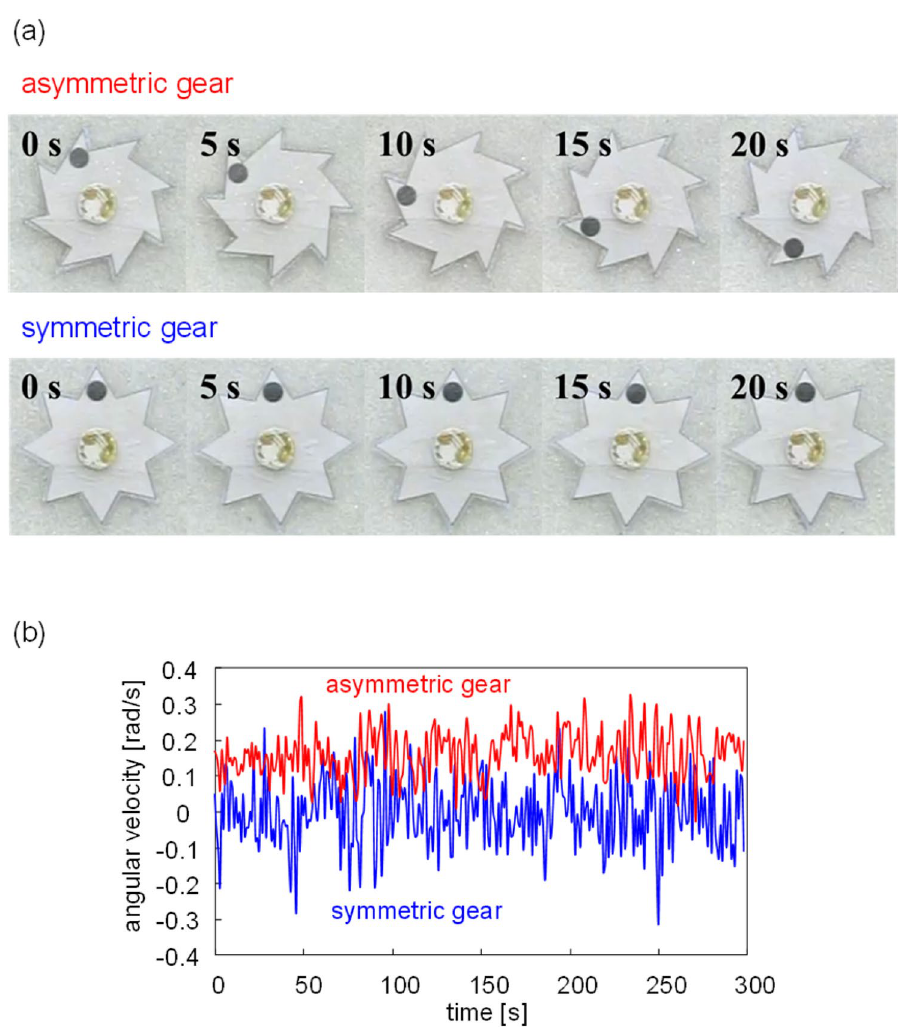
Figure 2. Motion of gear. ( a ) Snapshots of asymmetric and symmetric gears; ( b ) time course of angular velocity with bead diameter of 0.6 mm under 30